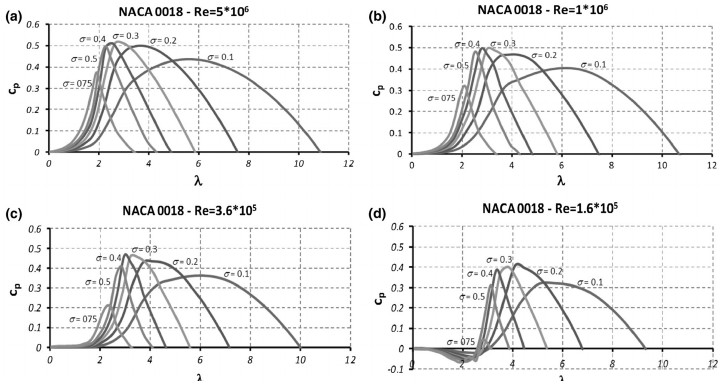
Figure 2. Curve of wind energy capture rate changing with blade tip speed ratio [19]. ( a ) the Reynolds number (5 ∗ 10 6 ) of the NACA0018 airfoil wind generator, ( b ) the Reynolds number (1 ∗ 10 6 ) of the NACA0018 airfoil wind generator, ( c ) the Reynolds number (3.6 ∗ 10 5 ) of the NACA0018 airfoil wind generator, ( d ) the Reynolds number (1.6 ∗ 10 5 ) of the NACA0018 airfoil wind